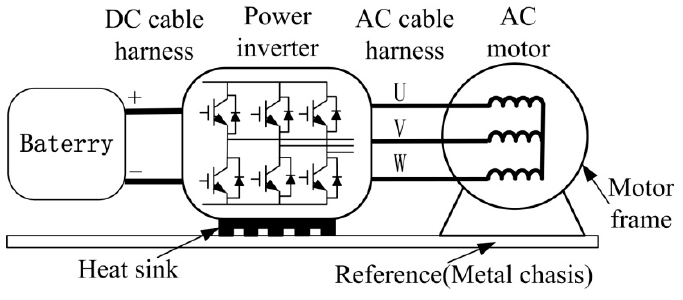
Figure 1. Power inverter system.